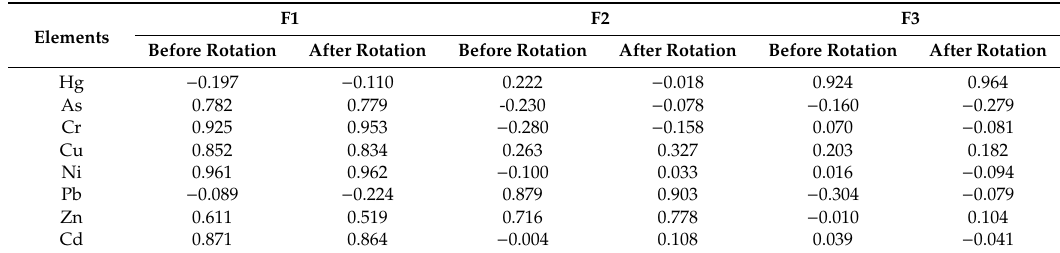
Table 8. Pre- and post-rotation factor load